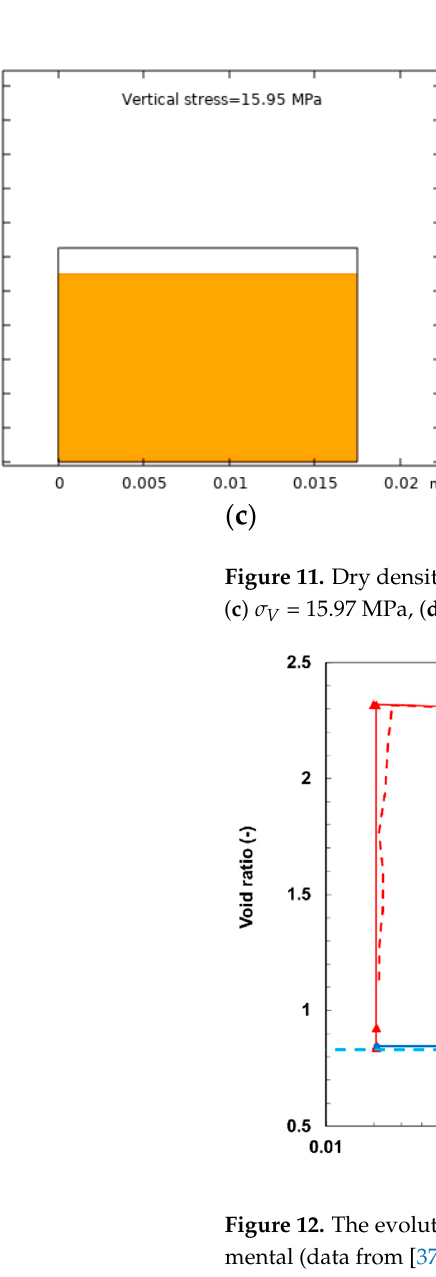
Figure 12. The evolution of void ratio during saturation and subsequent compression steps: exper- imental (data from [37] (CC BY 4.0)) and modeling results.